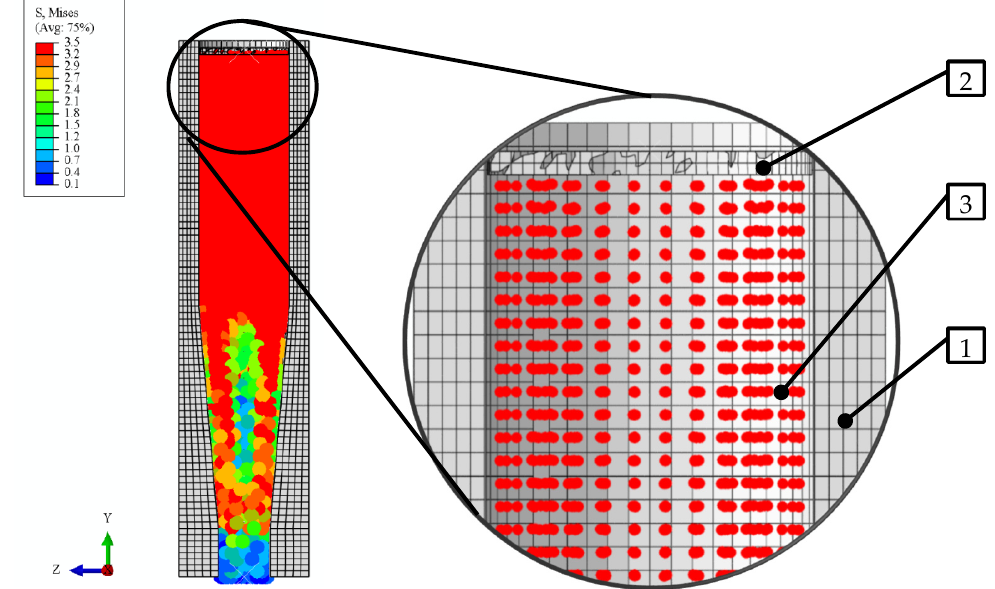
Figure 7. Distribution of particles in SPH analysis of the dry ice extrusion process: 1—integrated single-hole die, 2—ram, 3—particles of the extruded material.